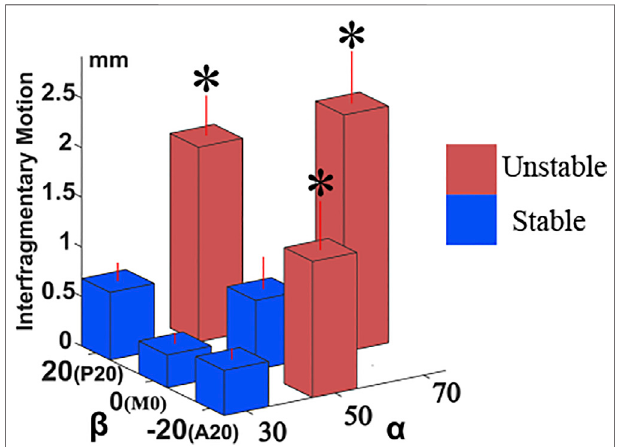
FIGURE 7 | The comparison of interfragmentary motion in biomechanical test. IFM plots as a function of α and β angles in the biomechanical validation test.Synbone ® fracturegroupswithcombinationsof α (cid:1) 70 ° ; α (cid:1) 50 ° and β (cid:1) 20 ° ; and α (cid:1) 50 ° and β (cid:1) 20 ° had signi fi cantly greater IFMs than groups with combinations of α (cid:1) 30 ° ( < 50 ° ),and α (cid:1) 50 ° and β (cid:1) 0 ° .TheseoutcomesofsimulatedFNFsinSynbones ® correspondwellwith clinical fi ndings. Asterisks indicate signi fi cance as evaluated by one-way ANOVA. Extent of group ( n (cid:1) 5) variability is standard deviation (SD) shown by red-colored vertical